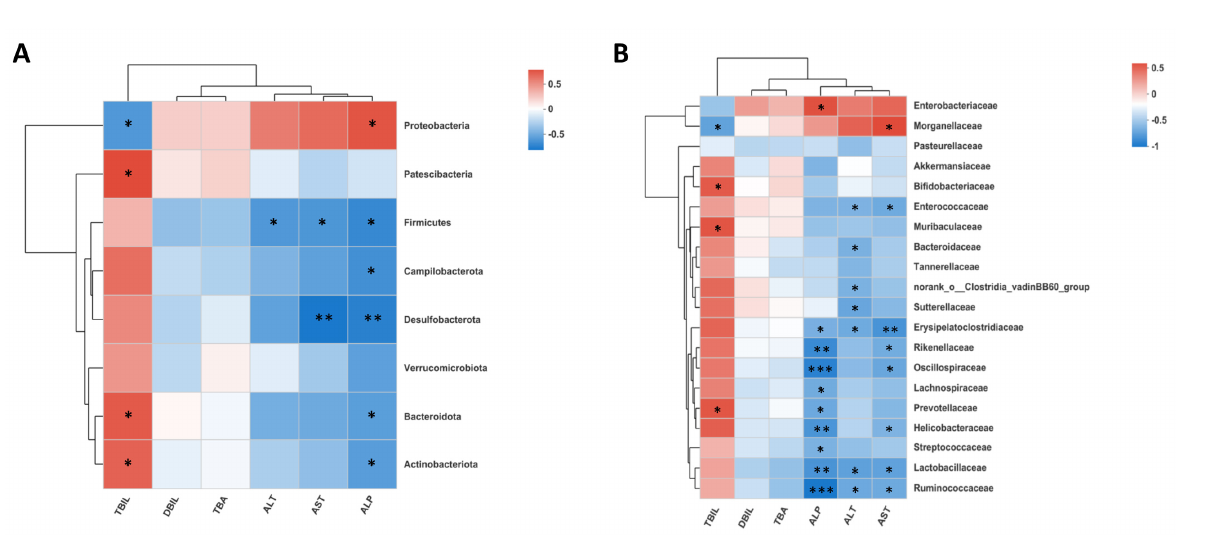
Figure 5. ( A ) The association between gut microbiota and serum markers of liver injury in AIMD_BDL group and BDL group at phylum level. ( B ) The association between gut microbiota and serum markers at family level. Red represents positive correlation, and blue represents negative correlation. * p < 0.05 ; ** p < 0.01; *** p < 0.001.